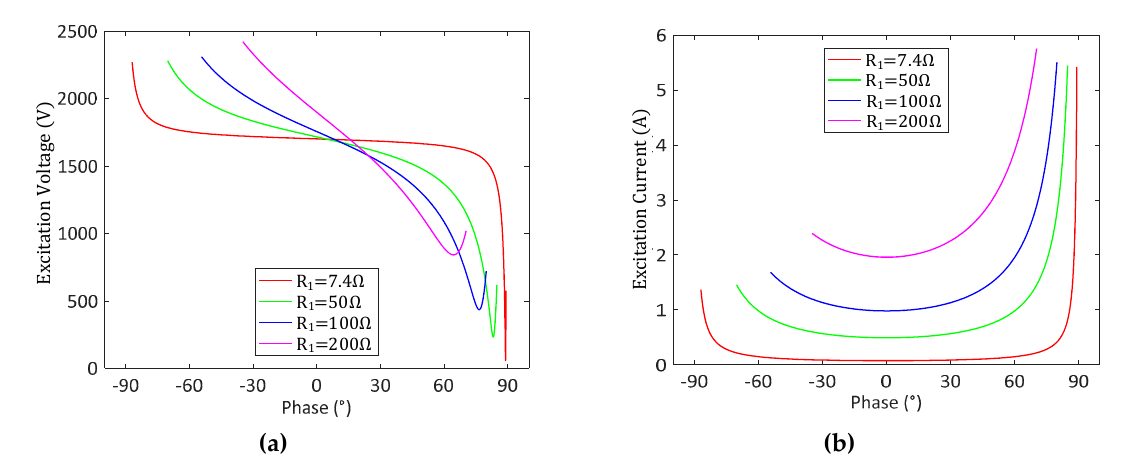
Figure 4. Variations in excitation voltage ( a ) and current ( b ) under different phase 𝜃 .